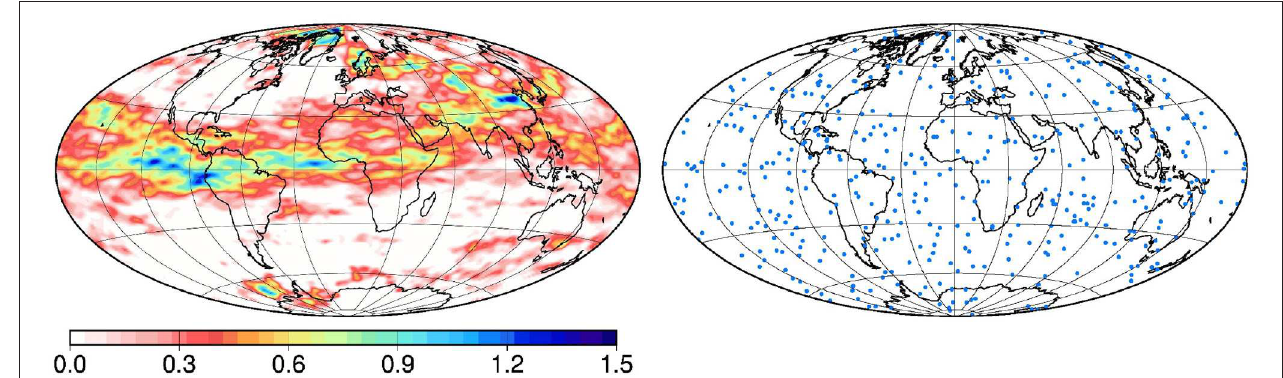
FIGURE 2 | True field x t (Left) and observation coverage (Right)